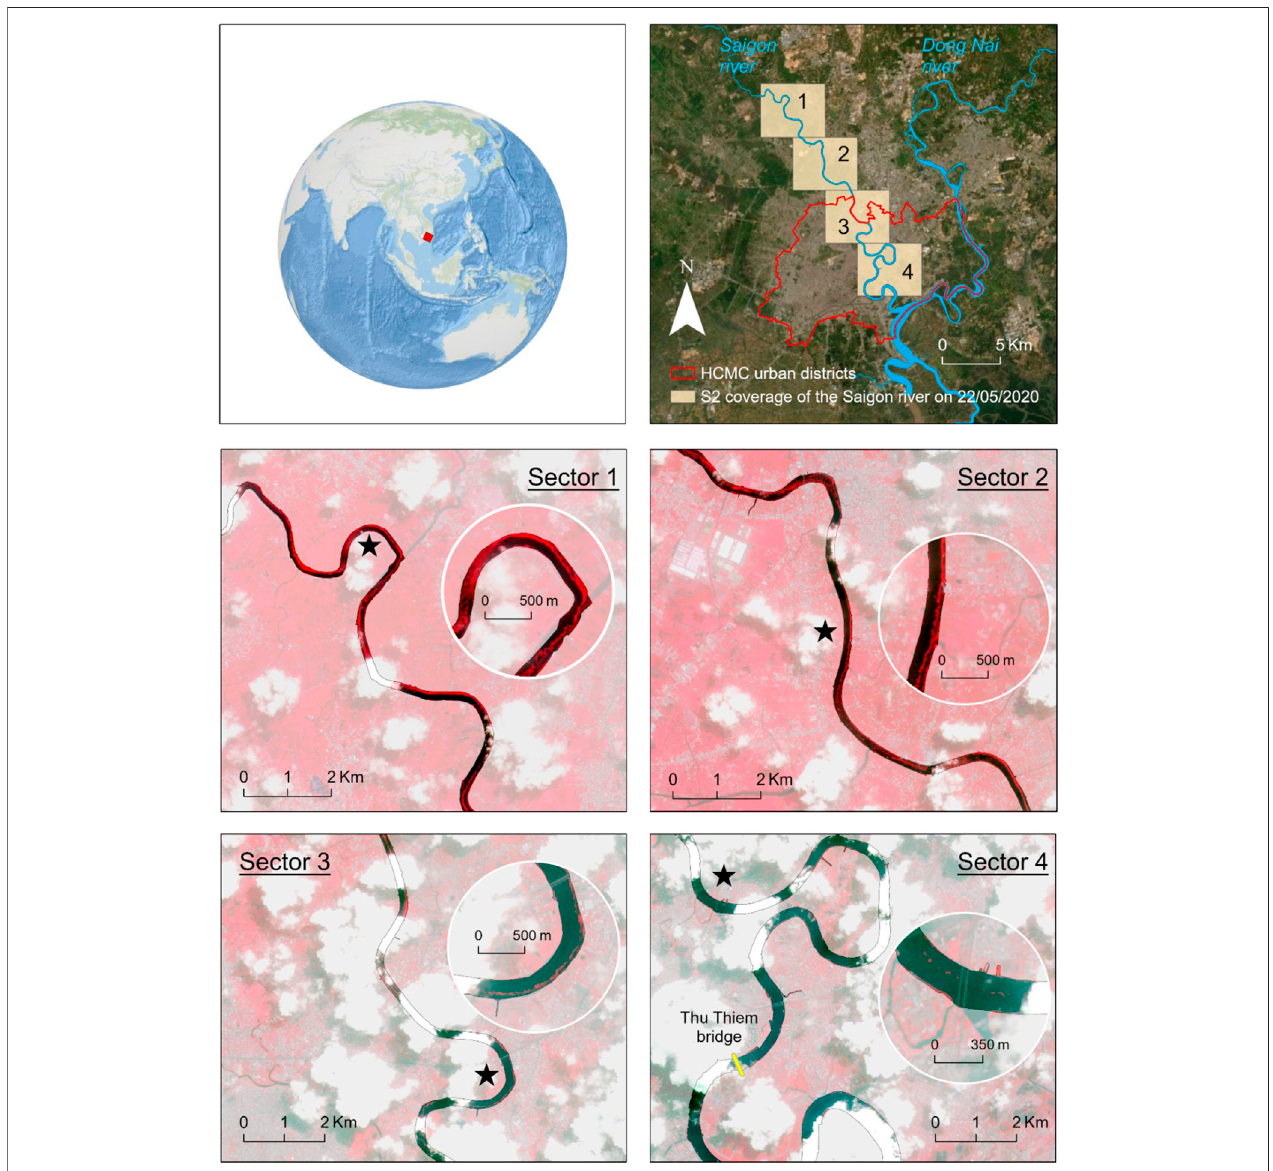
FIGURE 9 | Water hyacinths distribution maps over part of the Saigon river. Panel 1 indicates the localization of Ho Chi Minh City. Panel 2 shows the section of the Saigon river covered bySentinel-2 imagery taken on the May 22, 2020. Panels 3 – 6 display Sentinel-2 imagery with theFalseColor band combination (near-infrared, red and green bands). The stars indicate the approximate location of the detailed insetin each sector. Pixels withvegetation appear in red, pixels appearing in dark blue and black indicate water. Thu Thiem bridge is also indicated in Panel 6.